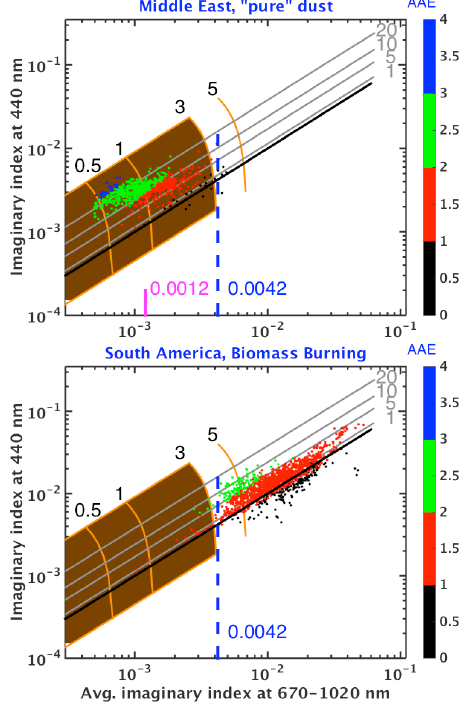
Figure 4. AERONET Level 2.0 imaginary refractive indices (color code corresponds to the absorption Ångström exponent). Top panel: data over the Middle East, filtered to retain only dust (i.e., require fine volume fractions less than 0.05 and depolarizations greater than 0.2 at the 532nm wavelength). Vertical magenta line denotes the median. Bottom panel: South American biomass burning sites for August and September. The vertical dashed line at k rnir = 0 . 0042 separates 95% of the two data sets. See Table 2 for a listing of AERONET sites used in these regions.